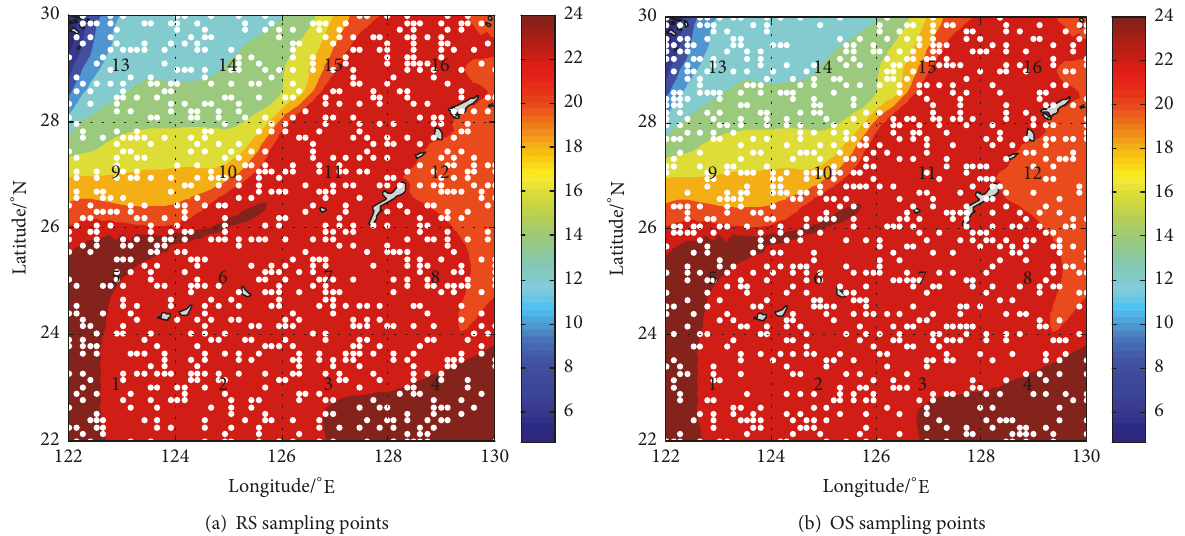
Figure 6: The distribution of sampling points.